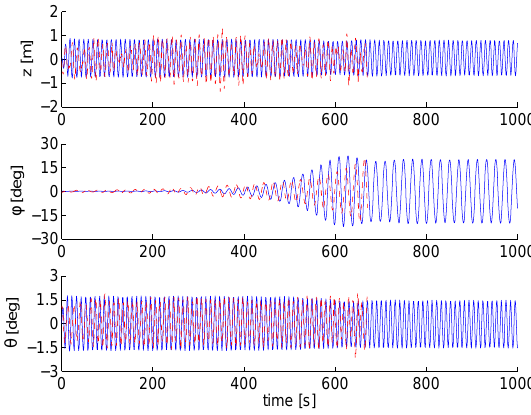
Figure 18: Exp. 1188. Exp. dashed red, sim. solid